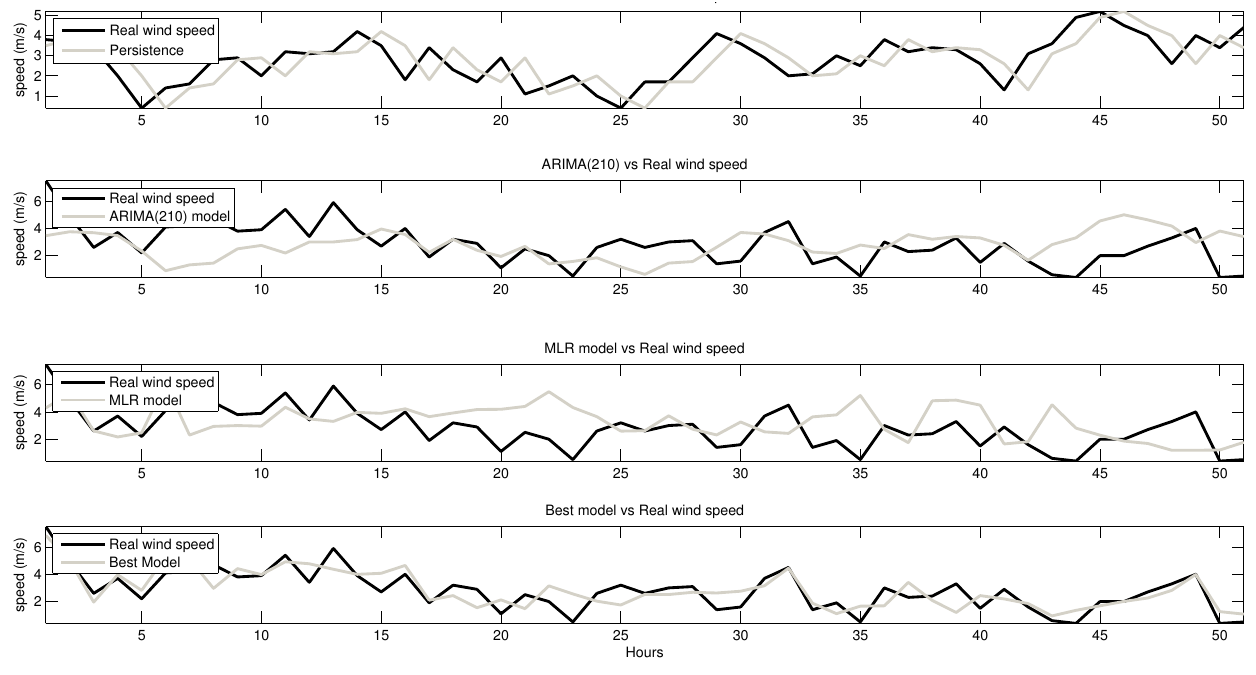
Figure 11. Original time series and forecasted data with the best obtained model.